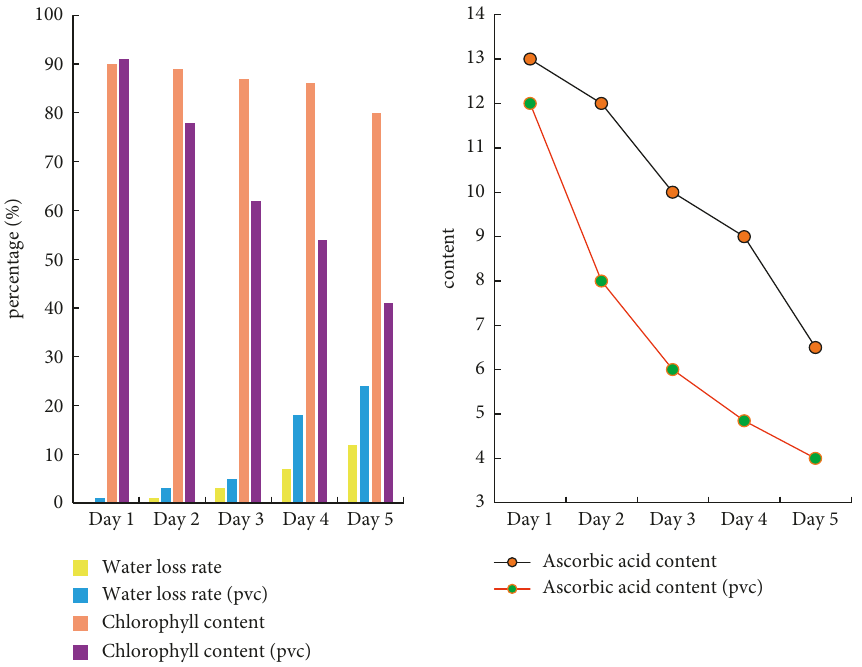
Figure 5: The results of the fresh-keeping experiment based on vacuum precooling and PVC cling film.